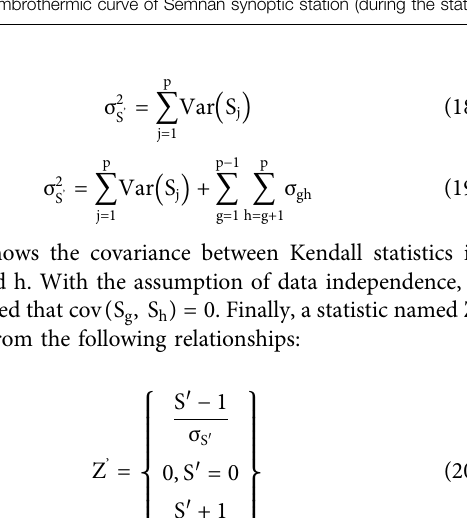
FIGURE 4 | Ombrothermic curve of Semnan synoptic station (during the statistical period).